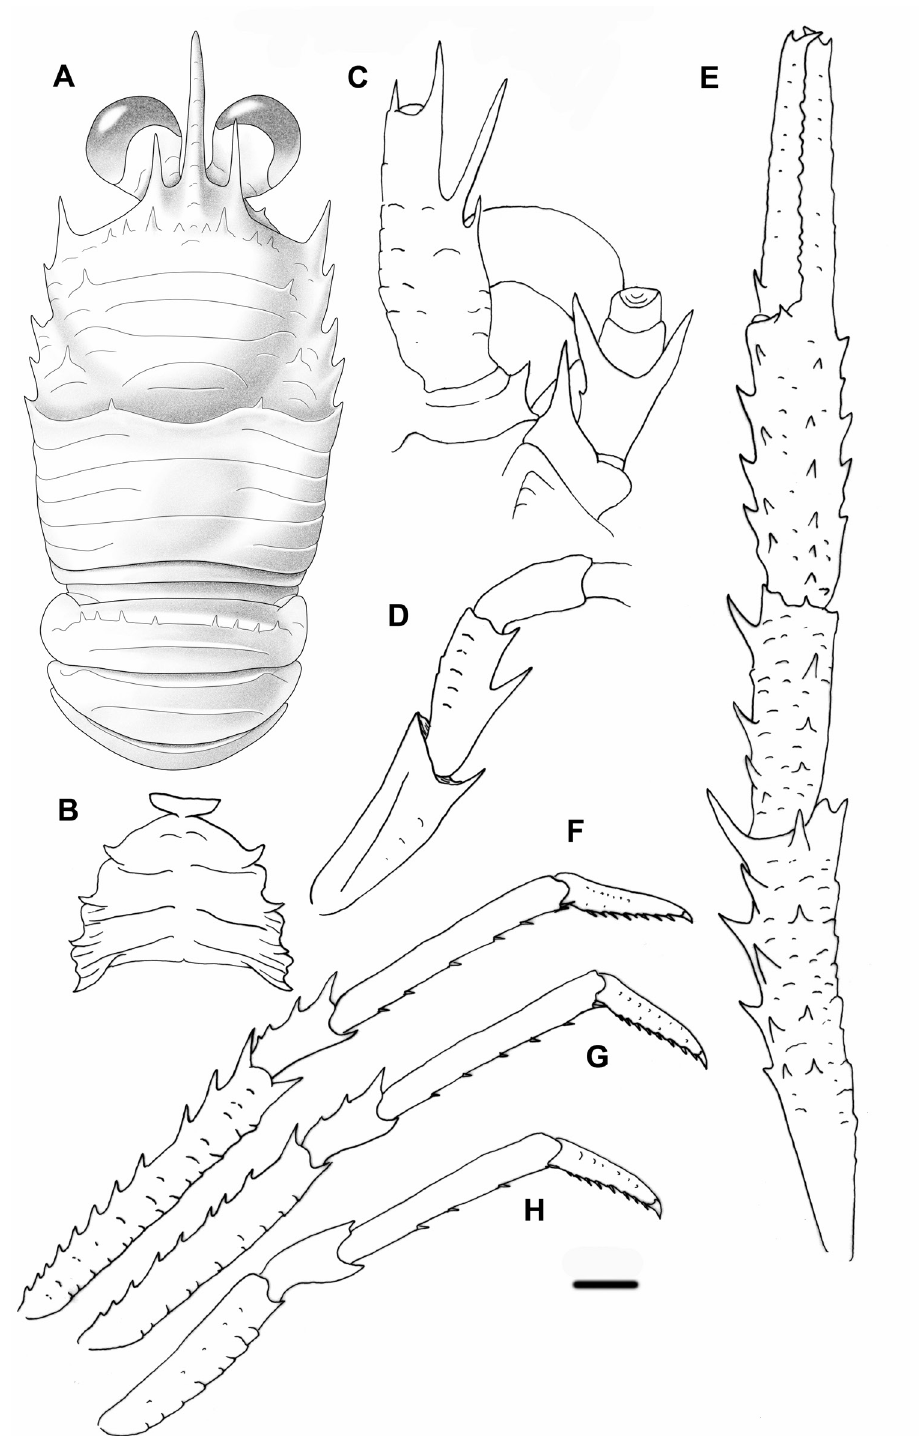
Fig. 3. Munida cristulata sp. nov., holotype, ♂, 6.1 mm (MNHN-IU-2014-13480), Glorieuses Islands, N of Mayotte Island. A . Carapace and abdomen, dorsal view. B . Sternal plastron. C . Cephalic region, showing antennular and antennal peduncles, ventral view. D . Right Mxp3, lateral view. E . Right P1, dorsal view. F . Right P2, lateral view. G . Right P3, lateral view. H . Right P4, lateral view. Scale bar: A–B, E–H = 1.0 mm; C–D = 0.5